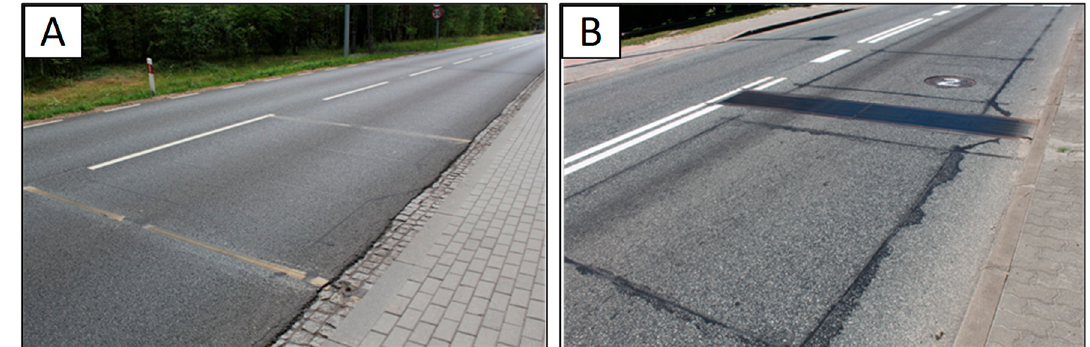
Figure 3. The investigated technologies of WIM axle load sensors: ( A ) quartz piezoelectric (piezoquartz); ( B ) bending plate. Table 1. List of WIM stations considered in the analysis and number of compound data records.